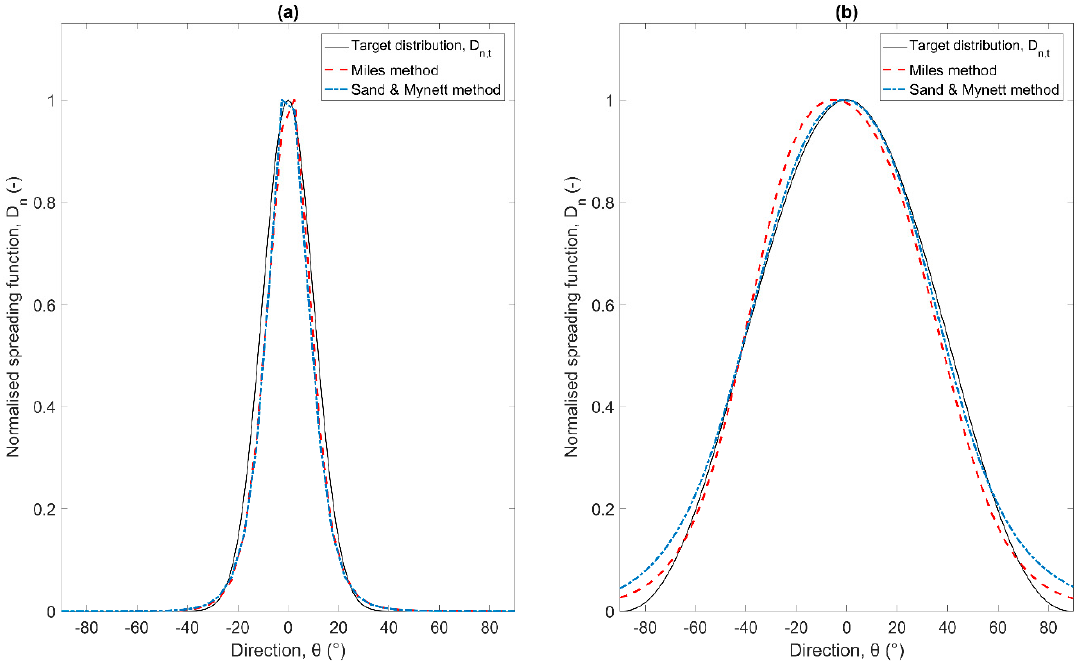
Figure 9. Comparison between the normalised spreading function distributions, D (cid:2924) , calculated in MILDwave with the Miles and the Sand and Mynett wave synthesis methods and the target distribution, D (cid:2924),(cid:2930) , for irregular short crested waves with a spreading standard deviation, σ (cid:2968) , of ( a ) 10° and ( b )